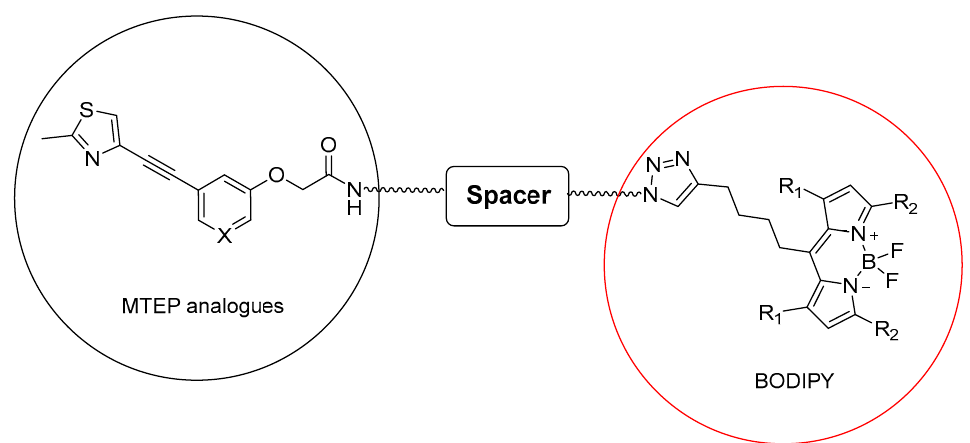
Figure 1. Schematic design of fluorescent mGlu 5 R ligands based on BODIPY.